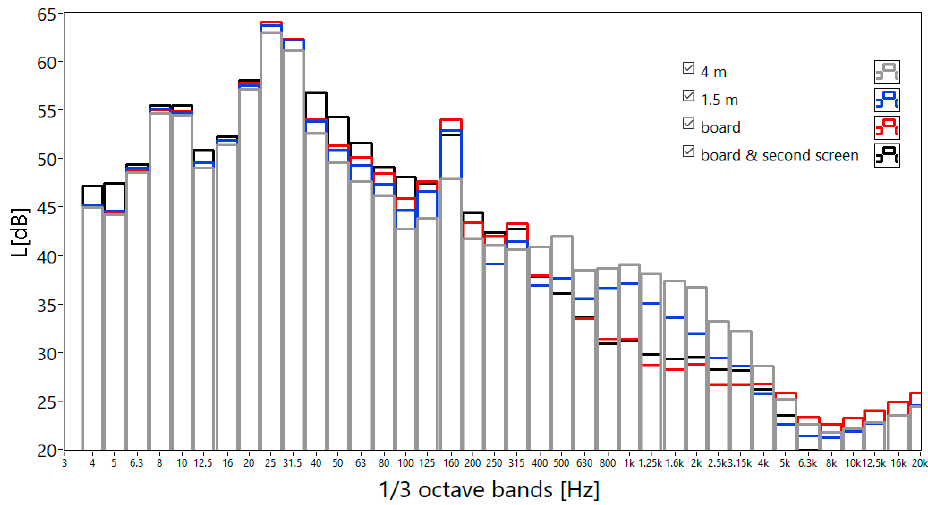
Figure 6. Ventilation shaft noise. One-third octave spectrum—wind speed 0 m/s.